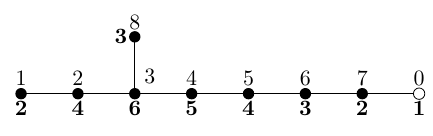
Figure 1 . The root lattice of affine E 8